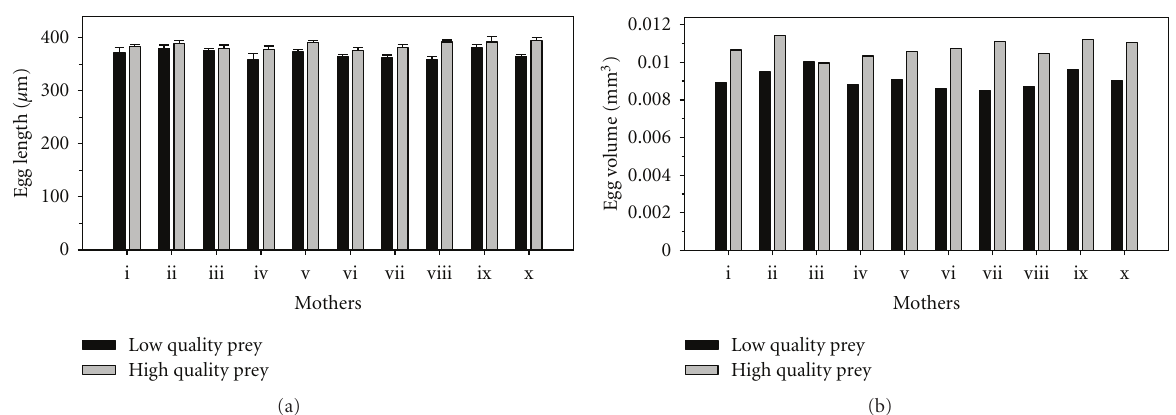
Figure 1: Mean ± SEM length (a) and volume (b) of eggs laid by 10 predators (mothers) fed high quality or low quality prey over combined harvest dates. Egg volume generated from mean egg length and mean egg width. High quality or low quality prey represent spider mites that fed on foliage of Fordhook or Henderson lima bean, respectively.